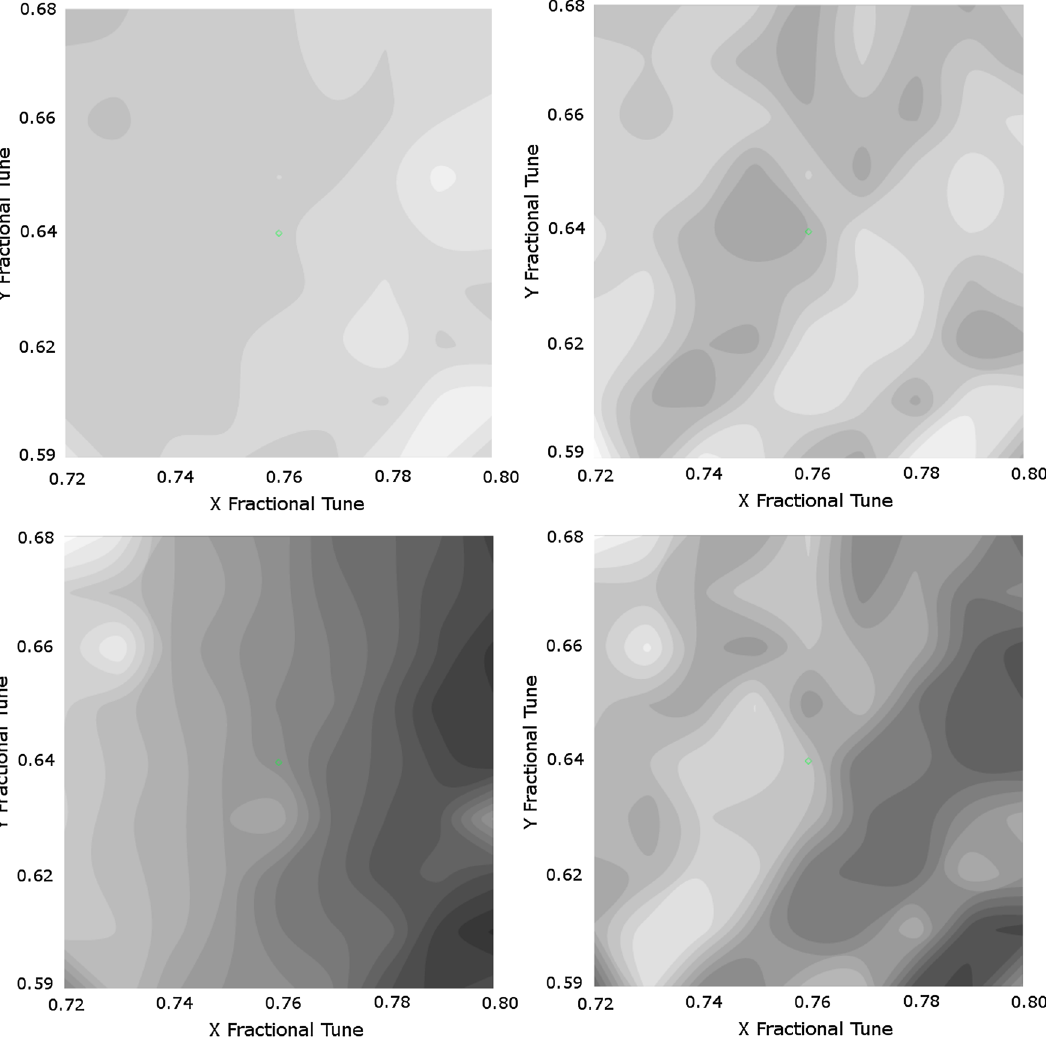
FIG. 8. Four contour plots of the dispersion across the scanned tune space. Darker areas denote lower levels of dispersion. The values are contoured between (cid:1) 0 : 02 m and 0.08 m. The locations for the upper left, upper right, lower left, and lower right are marked with the light blue, red, dark blue, and green points in Fig. 7, respectively. The green e symbol represents the location of the ideal